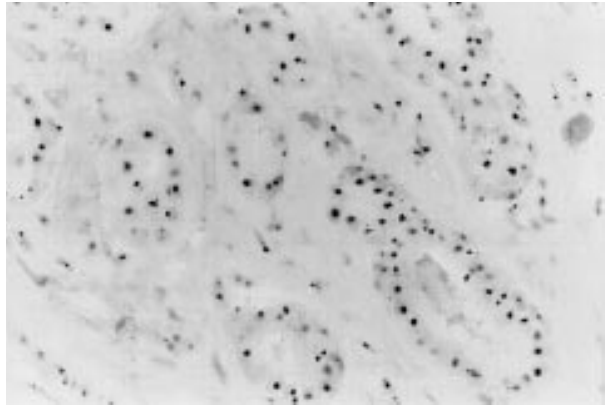
Fig. 1. Appearance of AgNORs in normal breast epithelial cells following standardised AgNOR-staining ( (cid:2) 400). All 4 AgNOR parameters were statistically significantly related in the 39 invasive carcinomas mea- sured. Statistically high significant correlation was found between mean values of AgNOR area and number ( R = 0.773), as well as between the CVs of area and number of AgNORs ( R = 0.747). Mean AgNOR values with their respective CVs were less significantly related or not at all (CV of area versus mean of area: R = 0.483; CV of number versus mean of number: R = 0.211, respectively) (Table